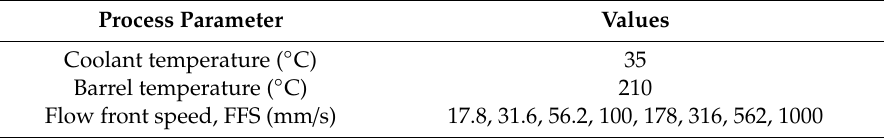
Table 1. Injection-molding conditions for the short-shot specimen.